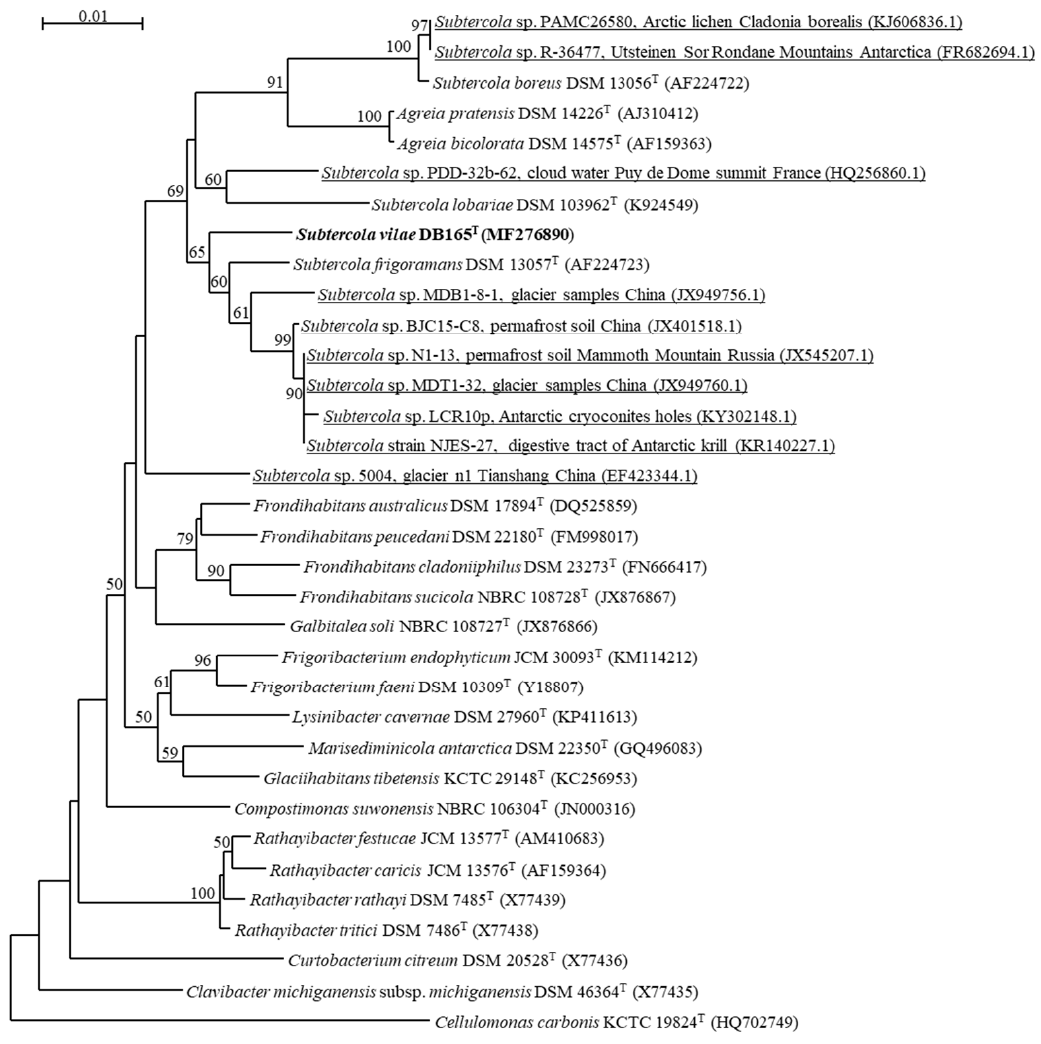
Figure 1. Phylogenetic tree based on the 16S rRNA gene sequences highlighting the position of Subtercola vilae DB165 T and other sequences annotated as Subtercola strains deposited in National Center for Biotechnology Information (NCBI), relative to phylogenetically closely-related type strains within the family Microbacteriaceae with 1000 bootstraps. Bootstrap values > 50% are indicated. Bar indicates 0.05 nucleotides substitutions per site.